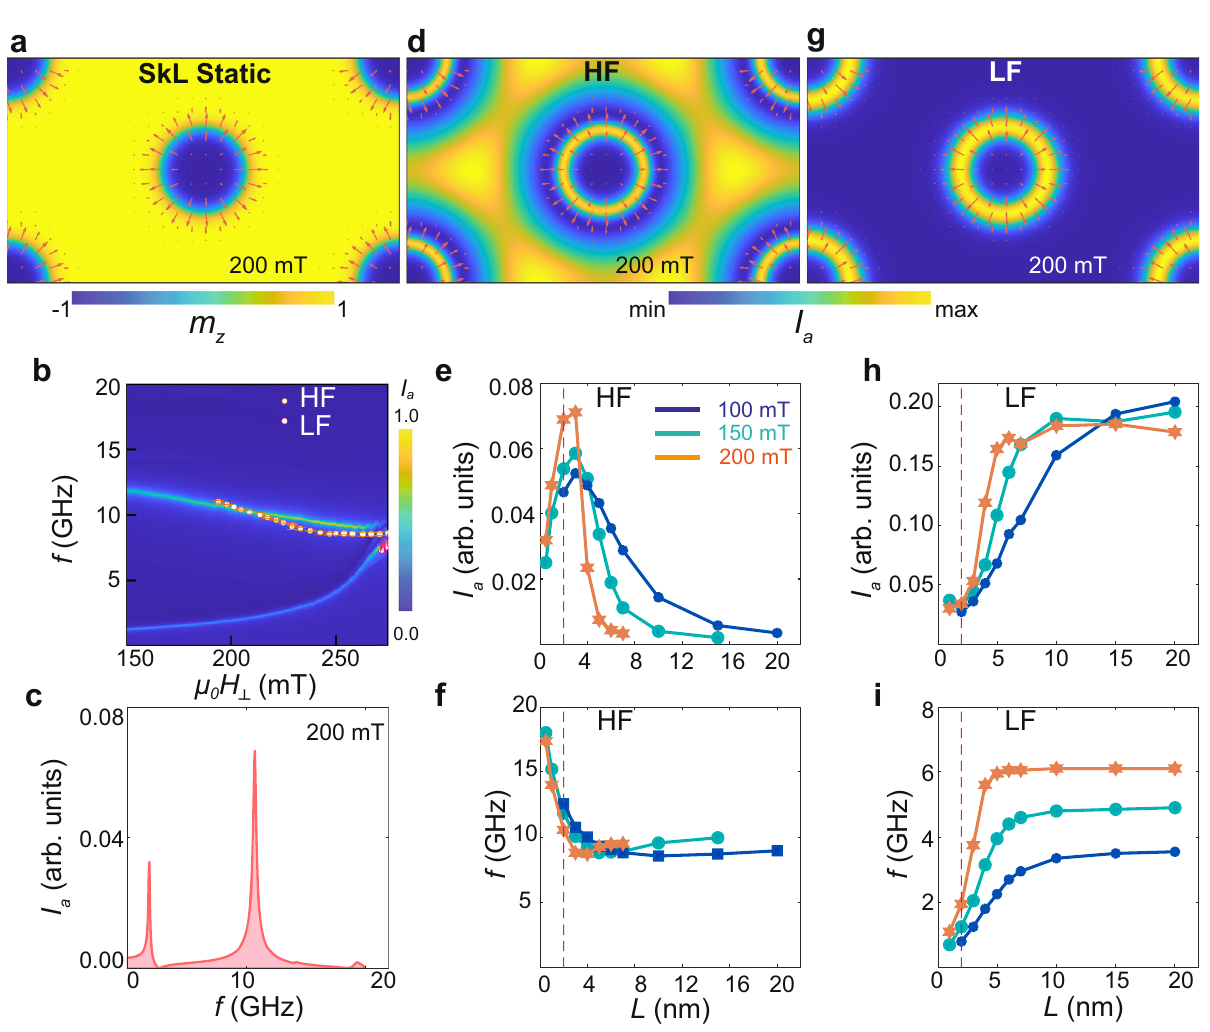
Fig. 5 Skyrmion lattice simulations exposing the delocalised HF resonance. We use a rectangular unit cell in a hexagonal skyrmion lattice containing ffiffiffi p two skyrmions, with area S uc ¼ 3 a 2 . The lattice constant a is adjusted such that the topological charge density ρ (2 × 2 μ m 2 ) relaxed sample at the same fi eld (Supplementary section II.C, Fig. S9). a Equilibrium magnetisation at 200 mT for a unit cell size 222 × 128 nm 2 . The colour scale and arrows represent the out-of-plane and in-plane magnetisations. b Simulated resonance spectra for the geometry described in ( a ). c Vertical linecut through the spectra in ( b ) at 200 mT, highlighting the relative intensity of the HF and LF modes. d , g Spatial distribution of the microwave absorption intensity during HF and LF resonances at 200 mT, excited at 10.6 and 2 GHz, respectively. While the distribution of the LF mode is localised close to the skyrmion core, the HF mode intensity is primarily concentrated in the inter-skyrmion area. Panels a – d and g are simulated with a spacer thickness L = 2 nm. Panels e , f and h , i depict the variation of the absorption intensities and resonant frequencies with L for the HF and LF modes, respectively. The red dashed line at L = 2 nm corresponds to the experimental layer